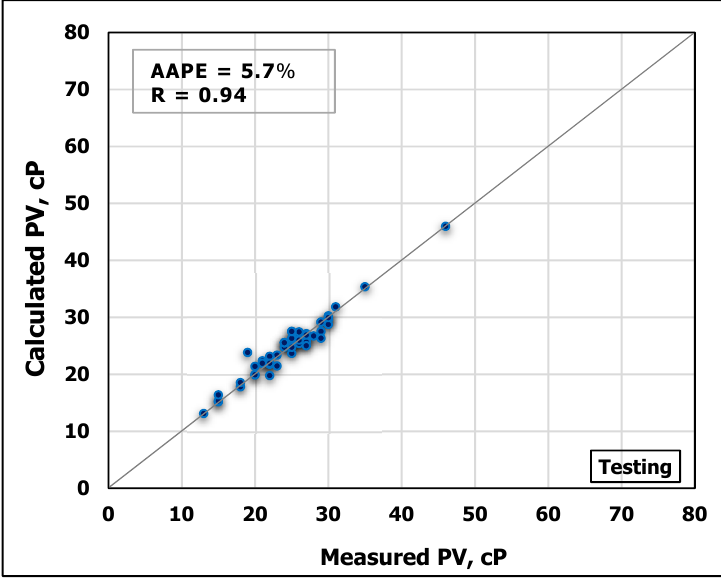
Figure 8. Measured PV vs. predicted PV from the ANN model for the testing process.